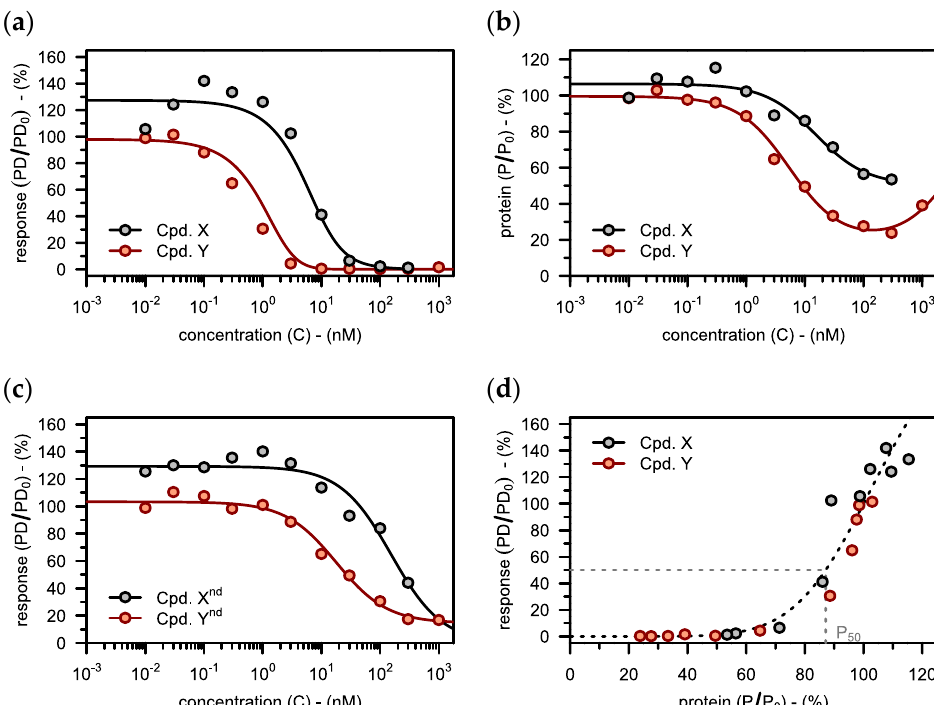
Figure 5. ( a ) The PD model is fitted to data on the downstream pharmacodynamic response (TNF-alpha levels) in the presence of various concentrations of the lead compound ( Cpd. X ). This analysis yields the target protein levels of half-maximal pharmacodynamic response ( P 50 = 87%) and an empirical hill coefficient ( n = 7). Subsequently, a target profile is defined for a potential follow-up compound ( Cpd. Y ). ( b ) Target protein levels (RIPK2) are plotted against drug concentration. The PD model is used to predict the target concentration-degradation profile for the follow-up compound from before ( Cpd. Y ). ( c ) The downstream pharmacodynamic response (TNF-alpha levels) is plotted against the concentration of the corresponding non-degrading (nd) control compounds. ( d ) The observed TNF-alpha response is plotted against the corresponding RIPK2 levels for both compounds. The dashed line shows the fitted PD model from before, but this time explicitly neglecting inhibition ( I = 0). Experimental data ( a – d ) taken from Mares et al.